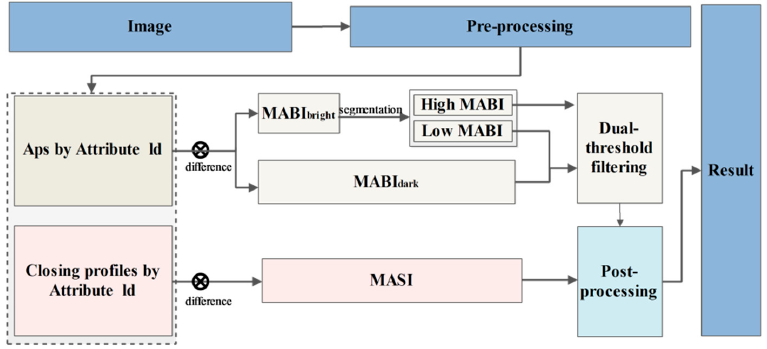
Figure 1. Flowchart of the proposed framework. Table 1. Notations used in this paper.